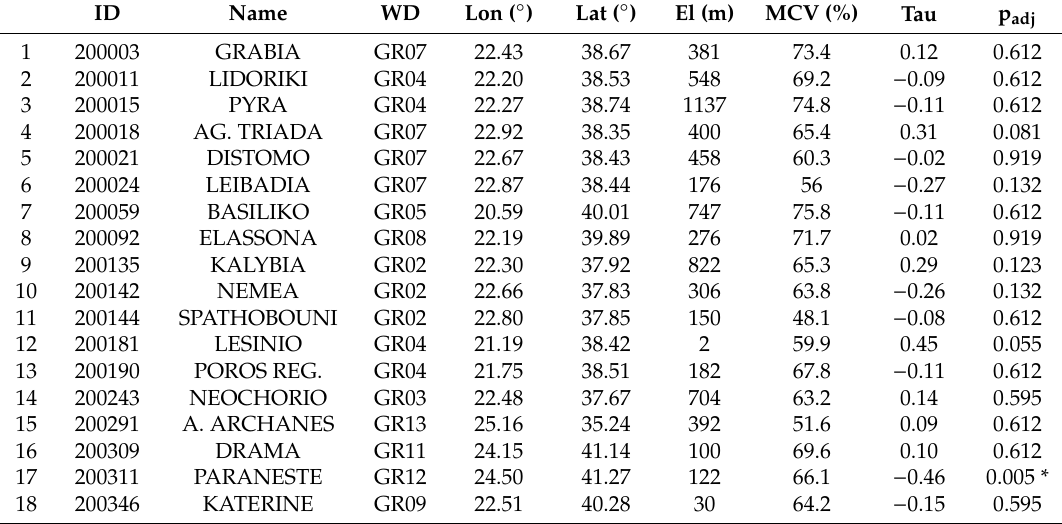
Table 2. Location and analysis results for the stations with a common time length during 1965–1996. ID is an abbreviation for the station ID as reported in the Greek National Bank of Hydrological and Meteorological Information, WD for the Greek Water Divisions, Lon for longitude, Lat for latitude, El for elevation, MCV for mean coverage per station, p adj is the adjusted p-value from the test using the Benjamini & Hochberg method. When a star is marked, it indicates the test results in which the null hypothesis is rejected for a significance level α = 5%.